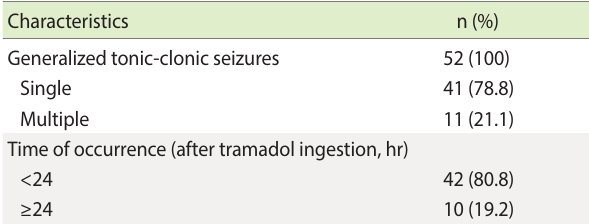
Table 3. Associations between study variables and the incidence of severe complications of tramadol overdose based on a backward